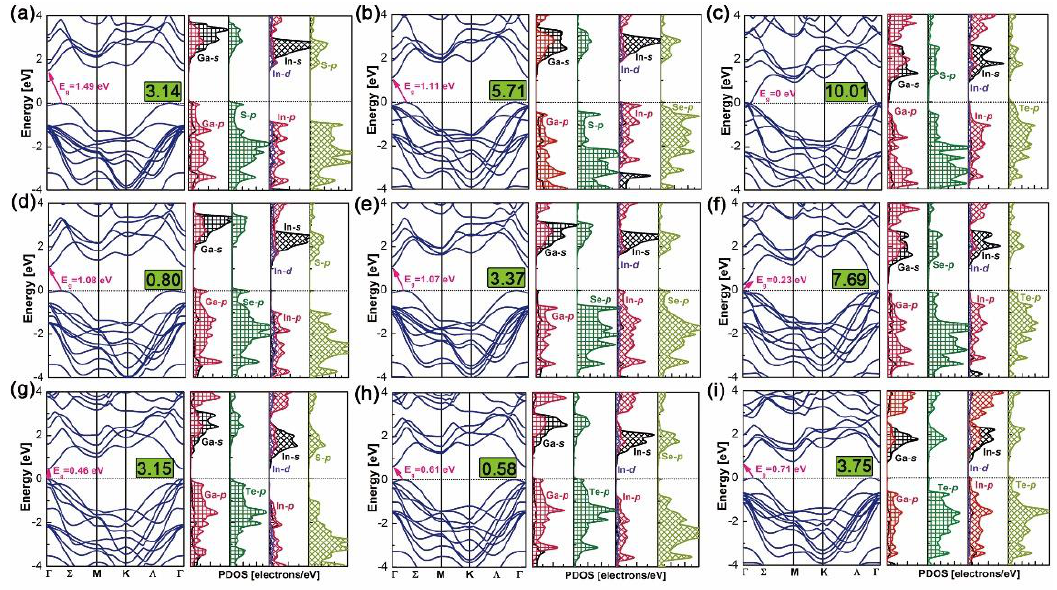
Figure 6. Band structures and density of states of N°1–9 GaX/InX ( a – i ). Numbers enclosed in green blocks are their in-plane lattice mismatches in %.